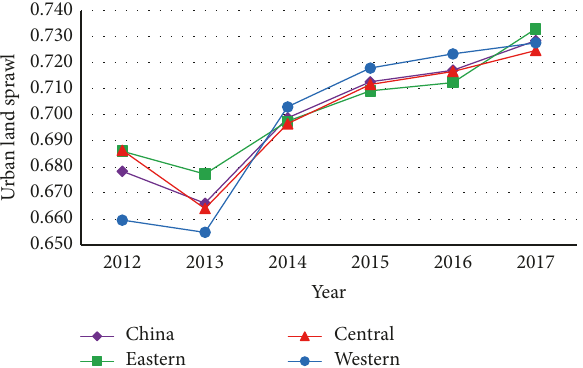
Figure 3: Urban land sprawl in China during